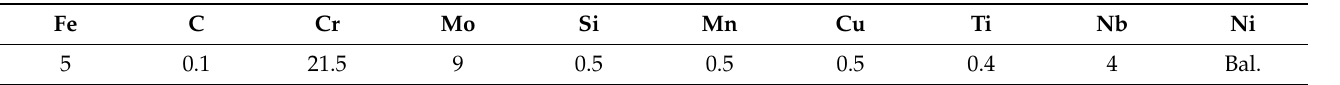
Table 2. Chemical properties of Ni625 powder